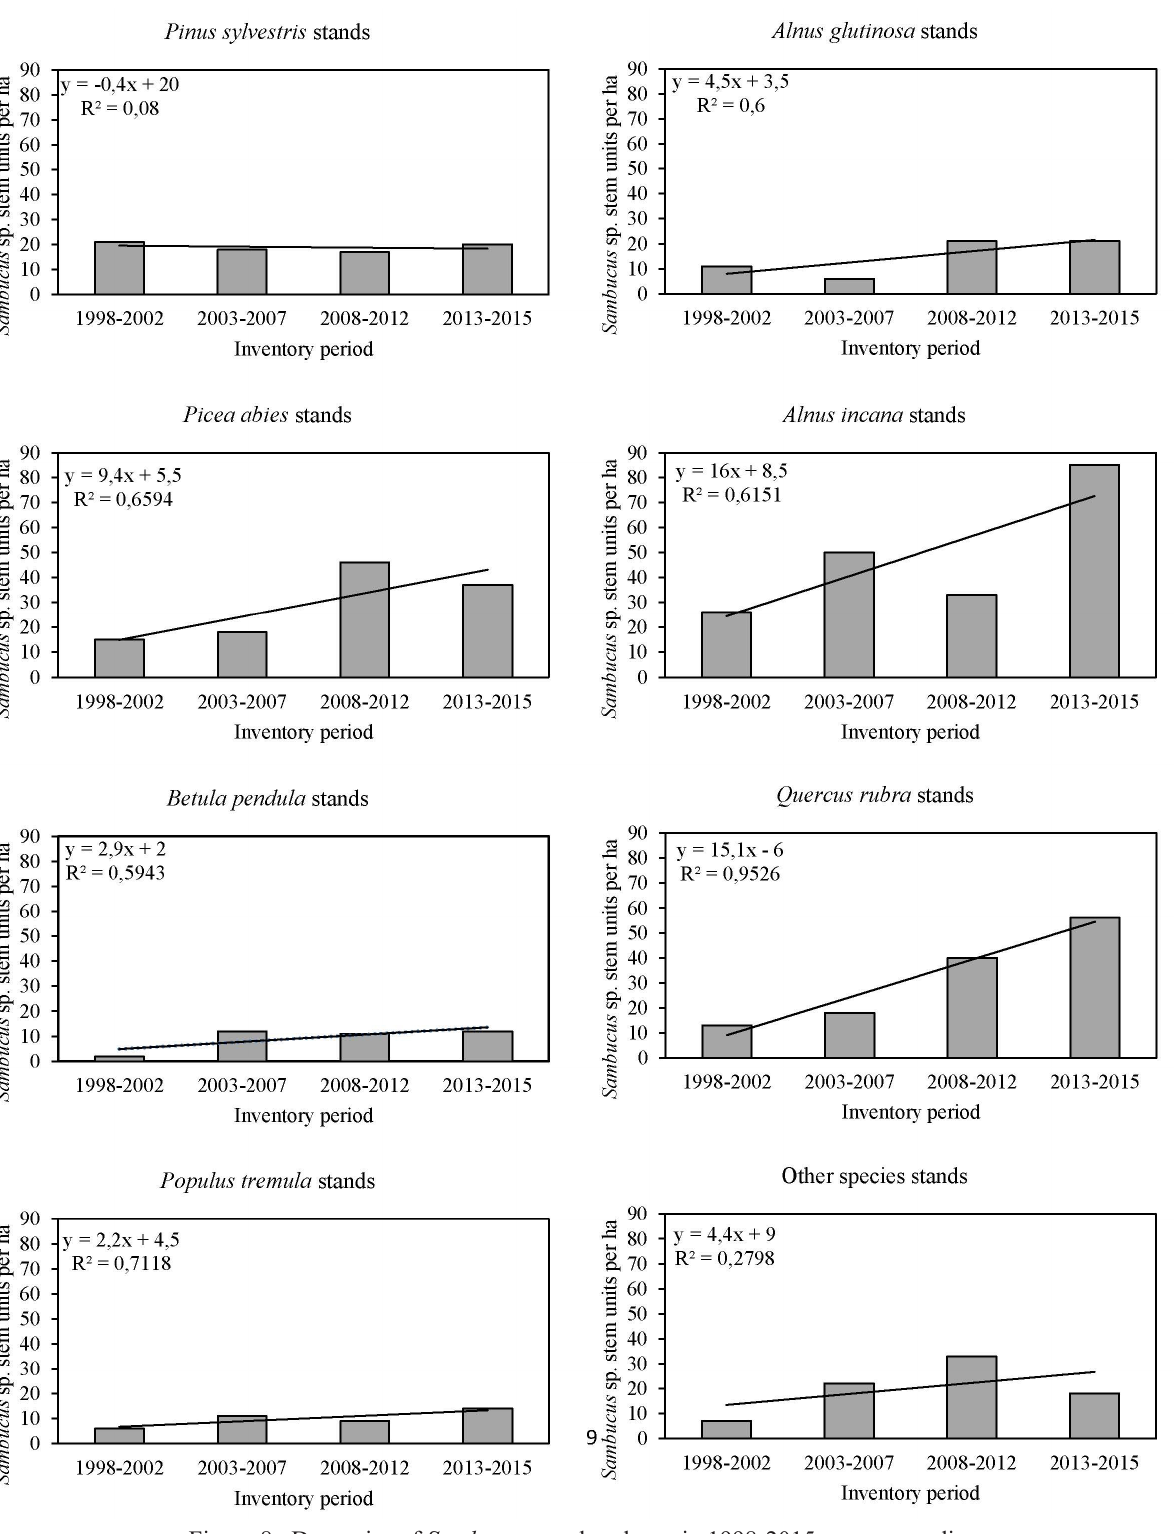
Figure 8. Dynamics of Sambucus sp. abundance in 1998-2015 years according the different dominated tree species, and number of individuals per